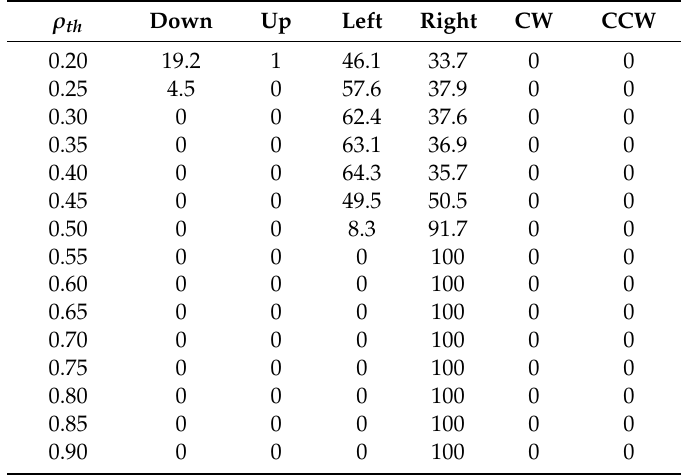
Table 3. Recognition probability of the “Right” gesture depends on the threshold value. ρ th Down Up Left